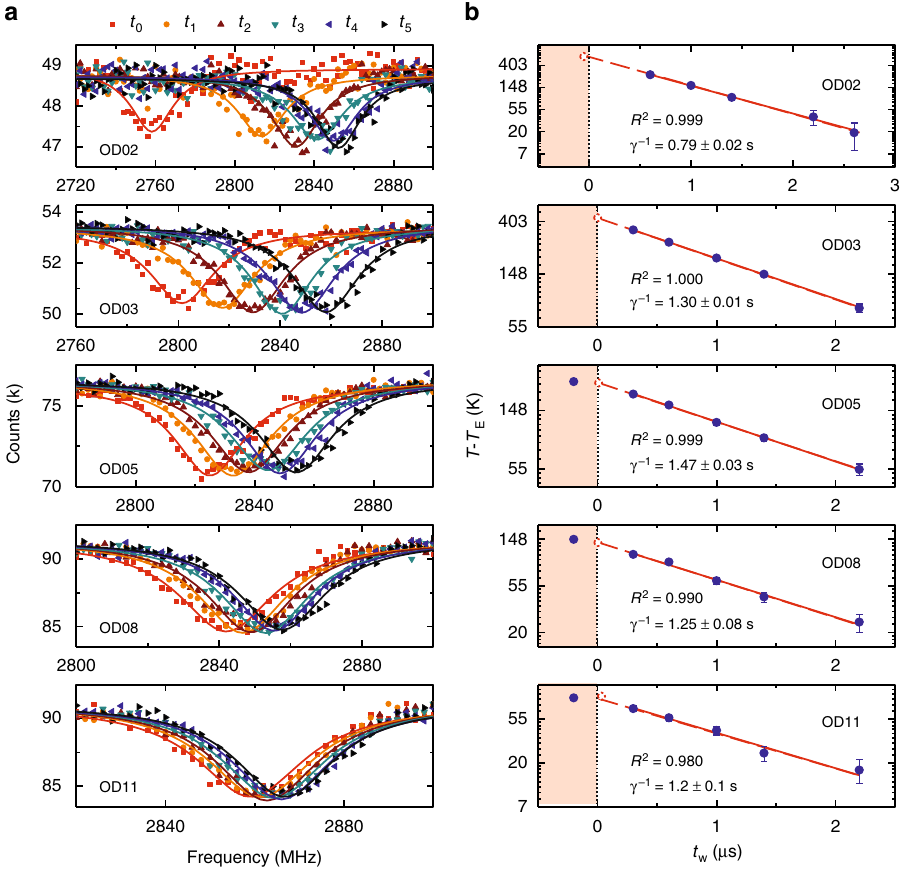
t = { − 0.2, 0.6, 1.0, 1.4, 2.2, 2.6} μ s for OD02, and t = { − 0.2, w w